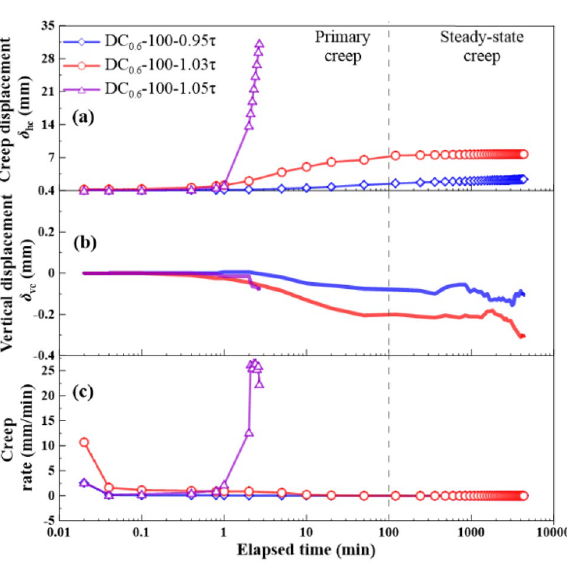
Figure 10. Relationships of ( a ) creep displacement ( δ hc ) versus elapsed time, ( b ) vertical displacement ( δ vc ) versus elapsed time, and (c) creep rate versus elapsed time for the reinforced specimens at ω = 18% under σ n = 100